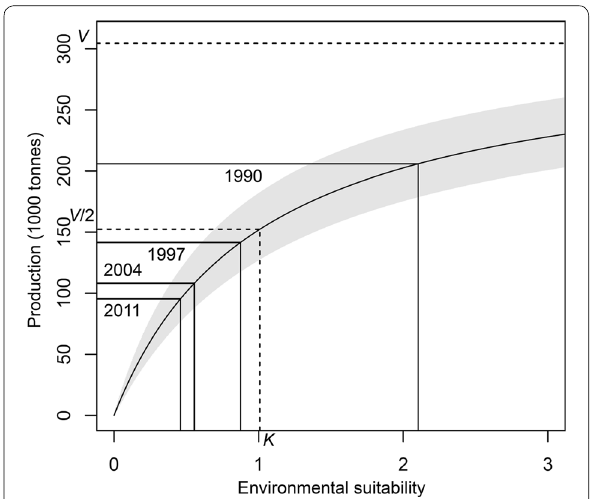
Fig. 5 Production-environmental suitability curve for seaweed in Japan. The gray band represents the band that corresponds to the standard deviation ( 0.5 SD) of the curve. V , maximum production; K , ± half-saturated